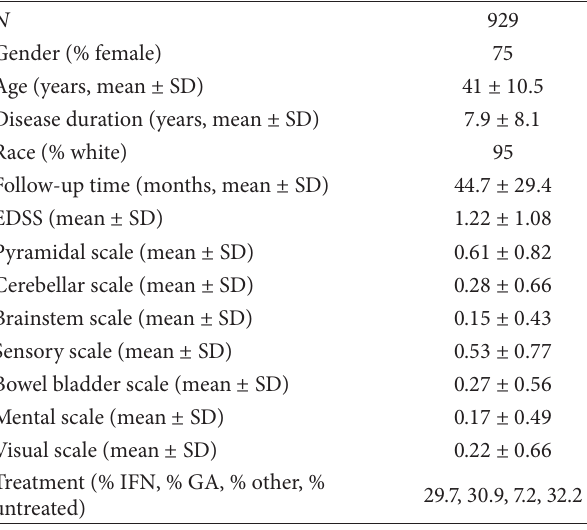
Table 1: Baseline demographic and clinical characteristics in study sample.